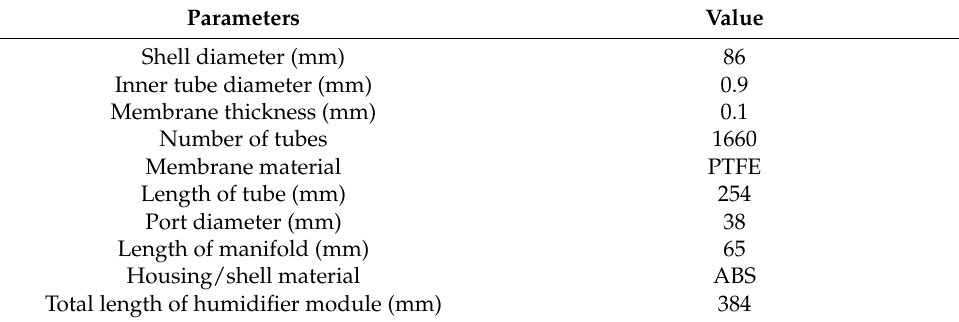
Table 1. Humidifier module and membrane